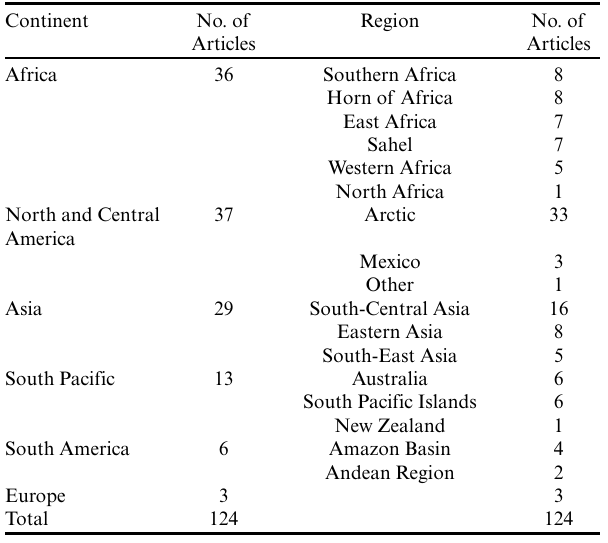
Table 2 outlines the geographic distribution of the studies in relation to continent and region. Table 2 . Geographic representation of articles